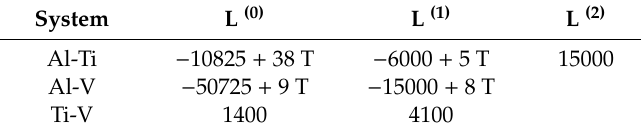
Table 4. Relevant parameters in the Redlich-Kister